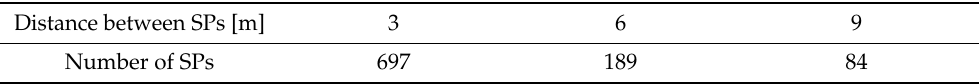
Table 2. Number of SPs vs. distance between SPs.